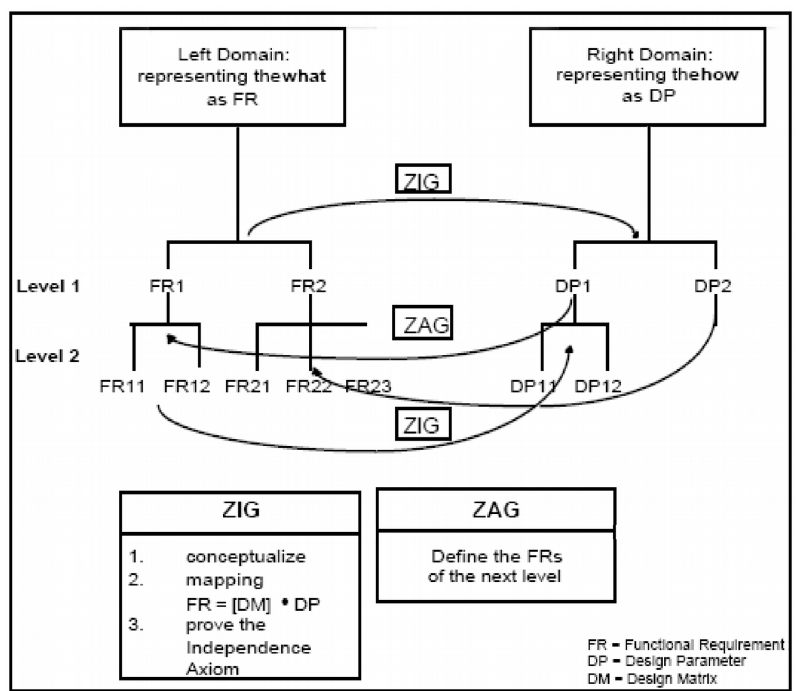
Figure 3. Zigzagging between the domains to develop the Hierarchy (Suh,